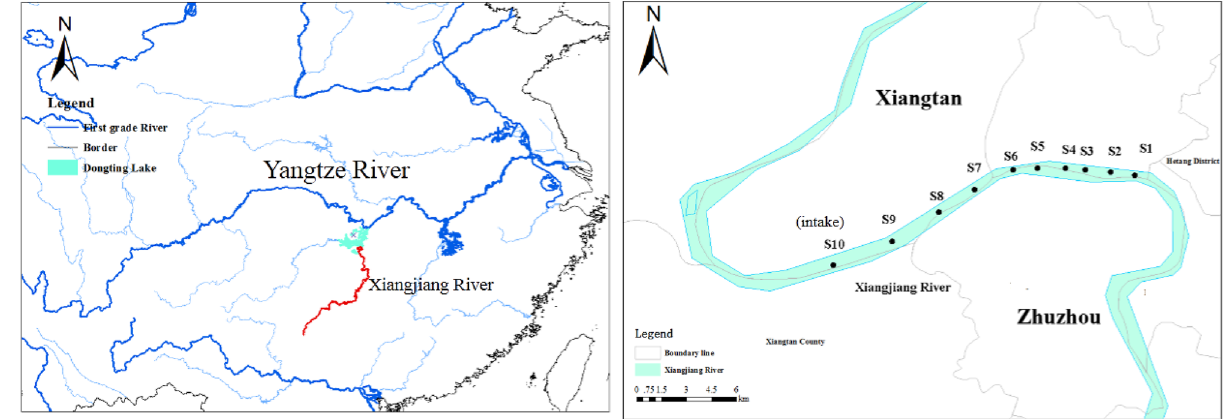
Figure 1. Map of the Xiangjiang River basin and the sampling